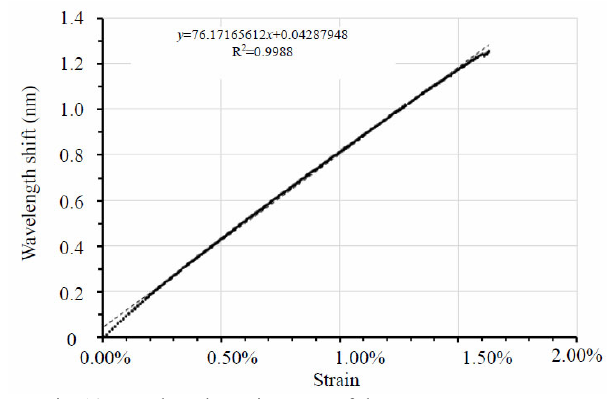
Fig. 10 Wavelength-strain curve of the